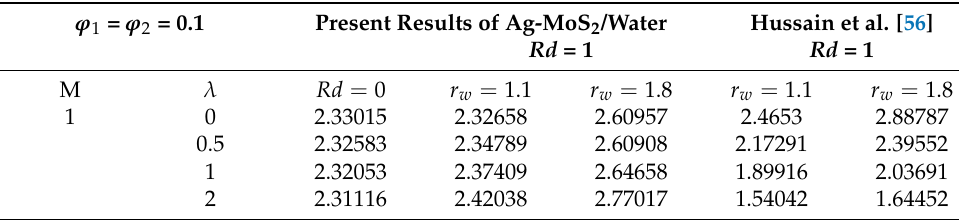
Table 6. A comparison of the Nusselt number of the present study under the nonlinear radiation effect with Hussain et al. [56].